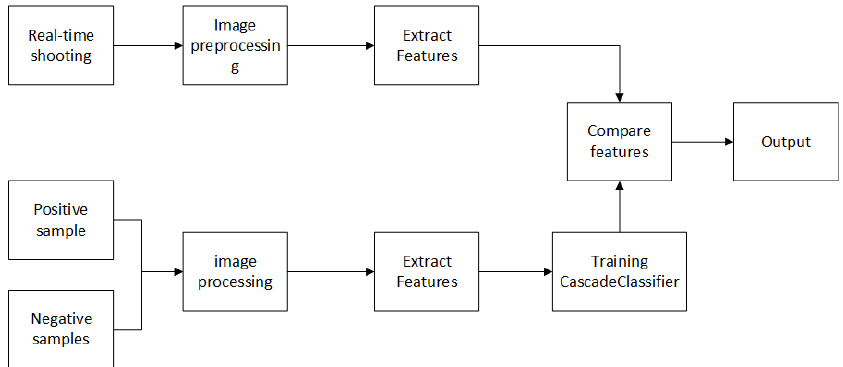
Figure 6. Identification flow chart.